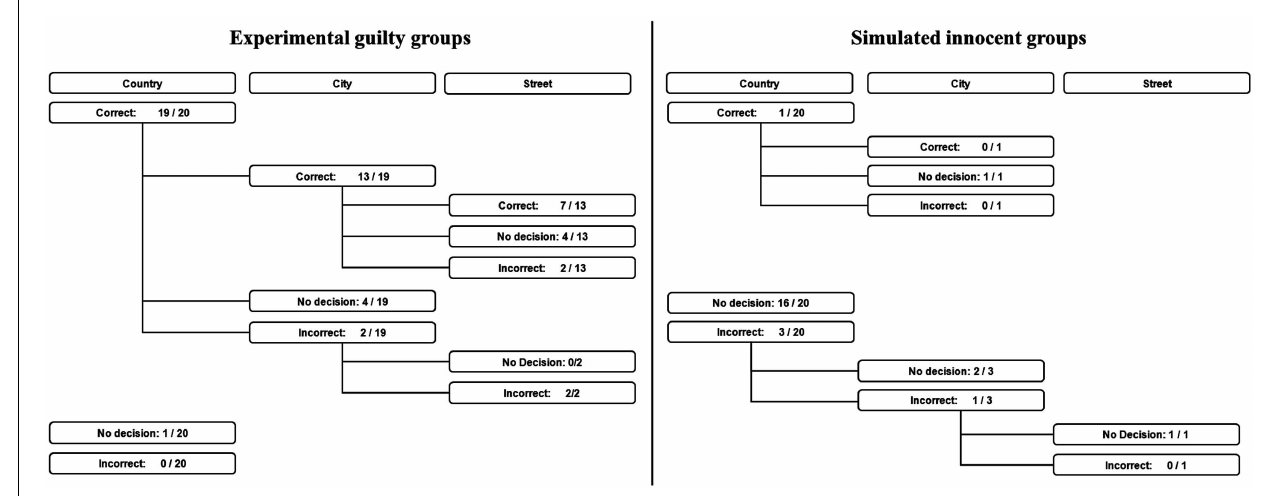
FIGURE 1 | Number of correct, incorrect and no decision verdicts for the three questions for the experimental participants (left panel) and the simulated innocent participants (right